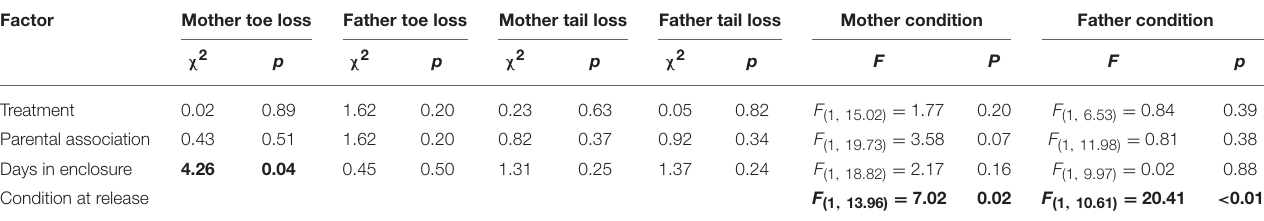
TABLE 3 | Output from models testing for effect of treatment and parent-offspring association on parental condition and harassment in Liopholis whitii .